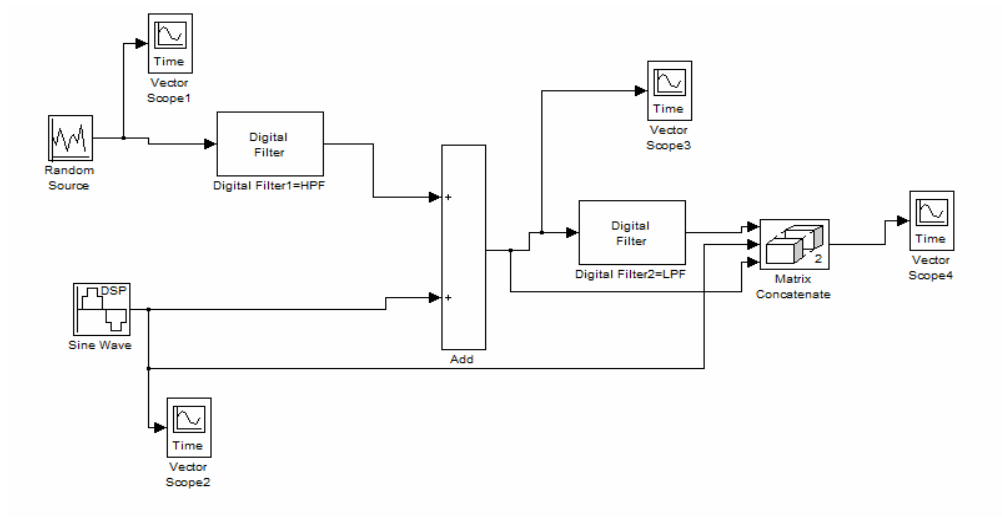
Figure 6. Simulink Model showing the implementation of FIR LP and HP filters designed by